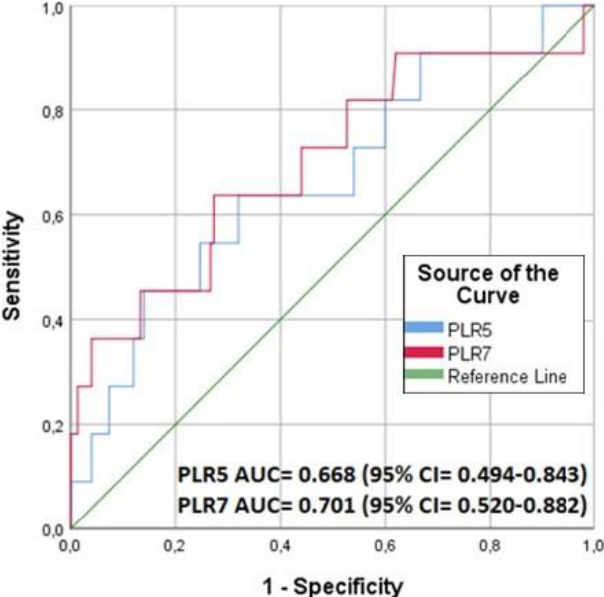
Figure 3. Receiver operating characteristic (ROC) curves for predicting 90-day mortality for platelet- 187 to-lymphocyte ratio (PLR) calculated on the 5th (PLR5) and the 7th (PLR7) postoperative day. 188